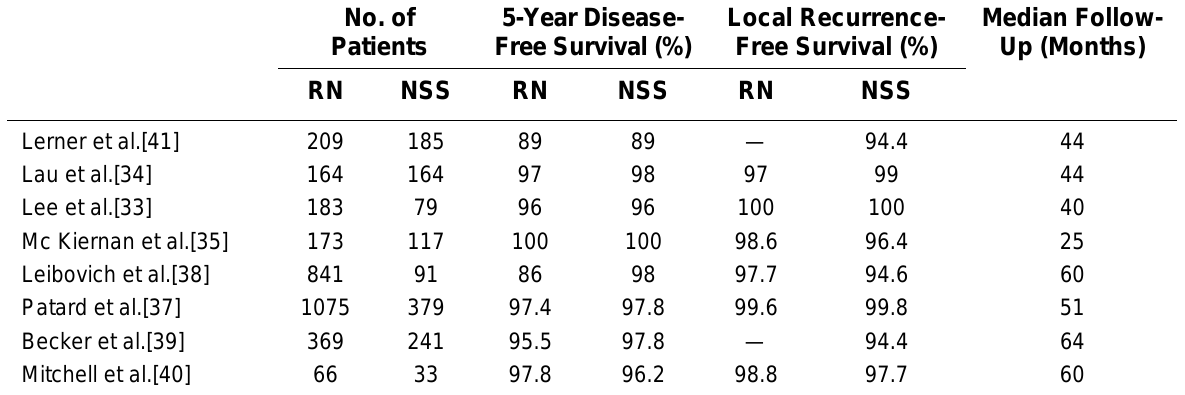
Recent Studies Comparing Cancer-Specific Survival in Radical vs. NSS